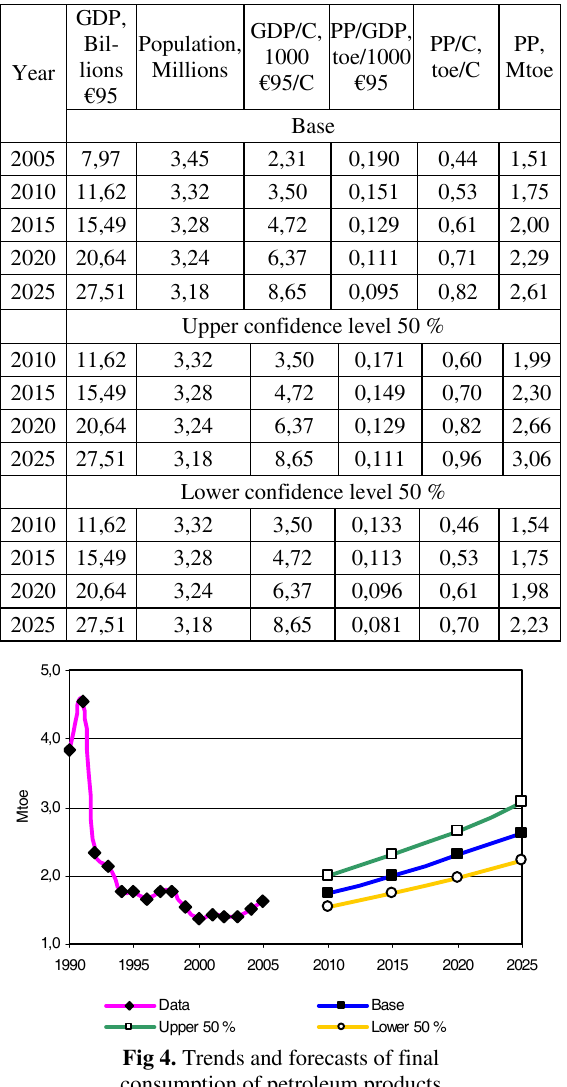
Fig 4. Trends and forecasts of